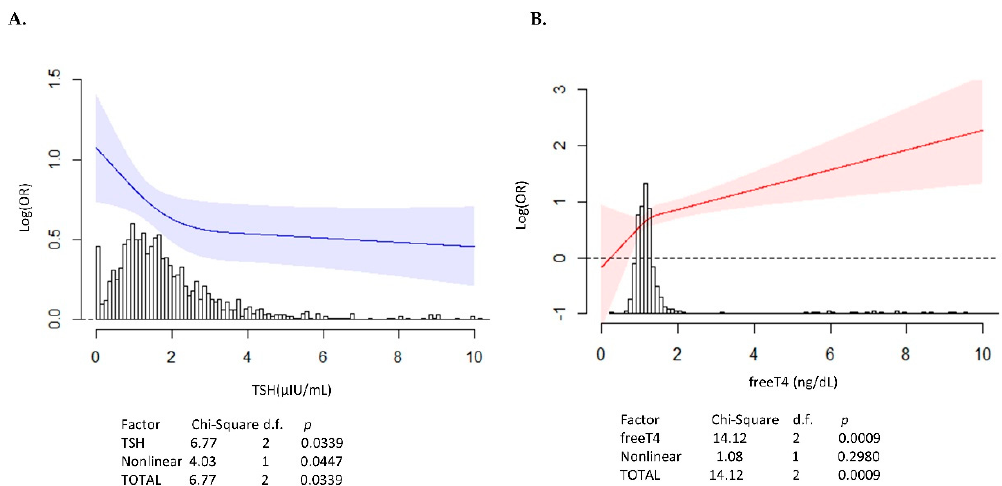
Figure 1. The association for TSH, free T4 level with VA development. ( A ) Plots of the estimated restricted cubic spline function relating TSH to VA development. The log-transformed odds of VA increased as the TSH level decreased, and the TSH level of 2 µ IU / mL was the knot and inflection point. There was a non-linear association between log-transformed odds of VA and TSH ( p -value = 0.0447). The solid line represents the estimated log OR of VA development, and the shaded area is 95% CI. Below is a density plot showing the distribution of observed TSH. ( B ) Plots of the estimated restricted cubic spline function relating free T4 to the VA. The log-transformed odds of VA increased as the free T4 level increased with linear association. The solid line represents the estimated log OR of VA development, and the shaded area is 95% CI. Below is a density plot showing the distribution of observed free T4. The dotted line represents when the OR of VA development is 1. CI, confidence interval; OR, odds ratio; TSH, thyroid-stimulating hormone; VA, vasospastic angina;T3, triiodothyronine;T4,